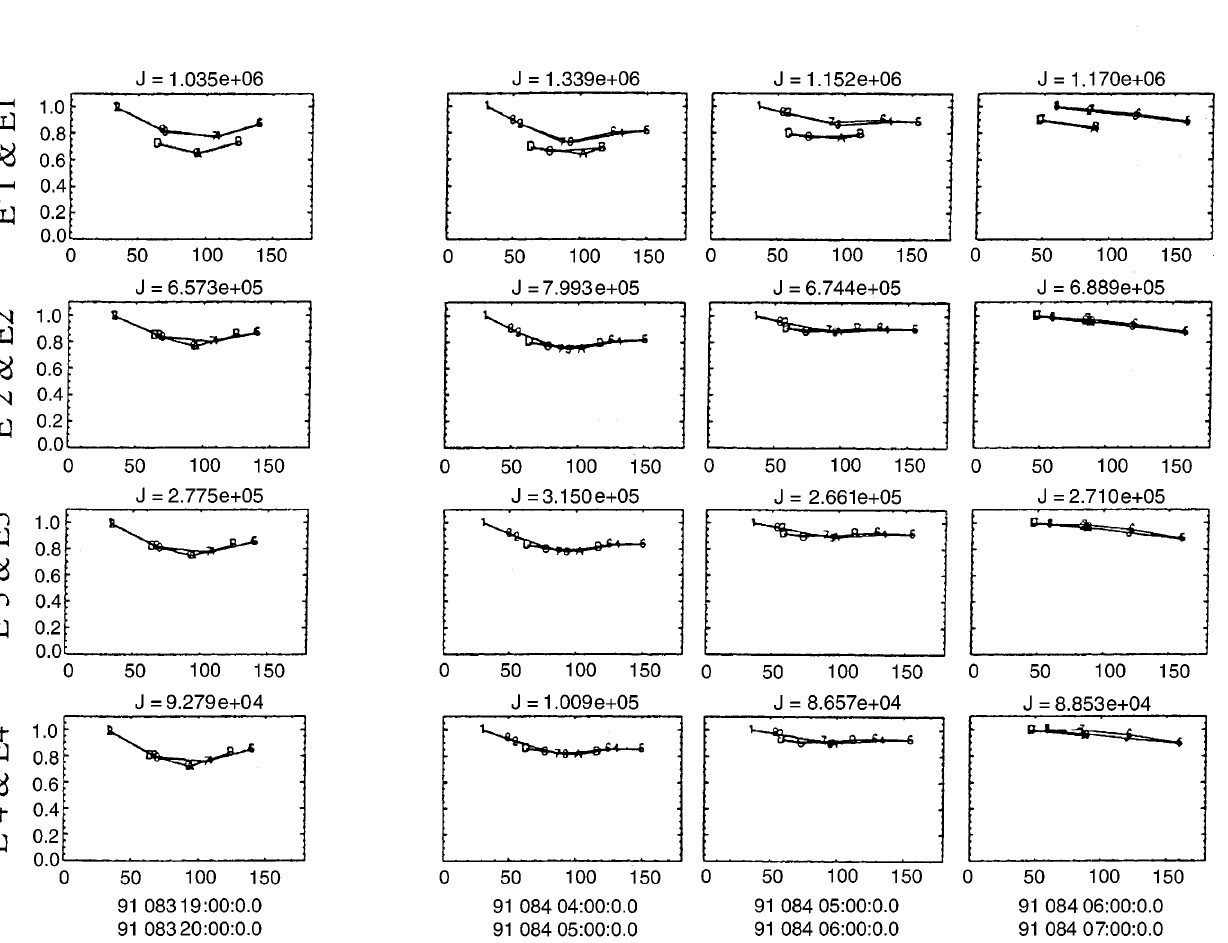
Fig. 2b. PAD snapshot for the electrons observed within region B , where Ulysses observes distinct electron bi-directional anisotropies. Electron anisotropy characteristics for the upstream and downstream regions of the shock, along with the PADs observed on shock arrival